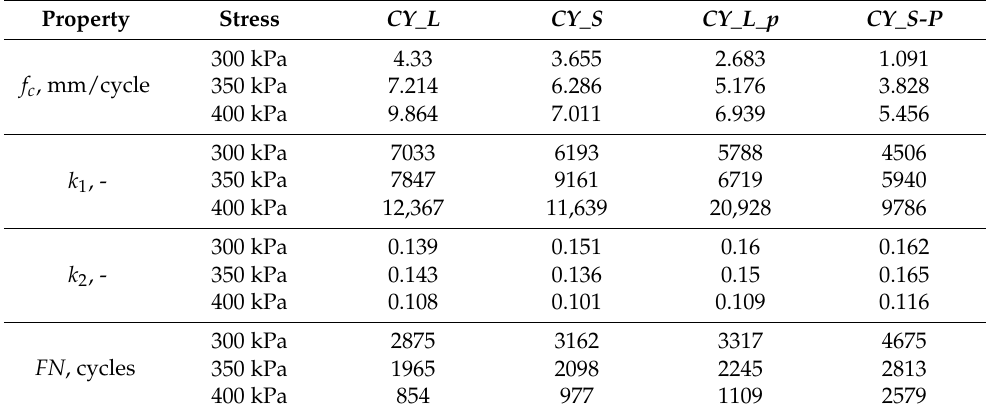
Table 4. Numerical RLA test results (60 ◦